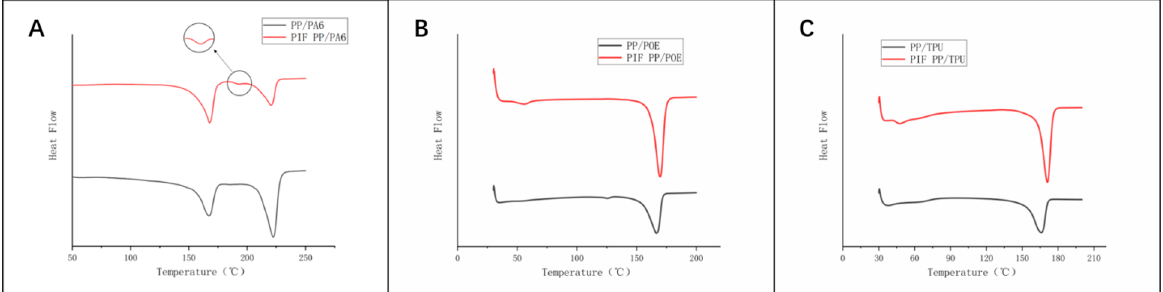
Figure 5. Differential scanning calorimetry ( DSC) spectra before and after PIF process, ( A ) PP/PA6 and PIF PP/PA6, ( B ) PP/POE and PIF PP/POE, ( C ) PP/TPU and PIF PP/TPU .